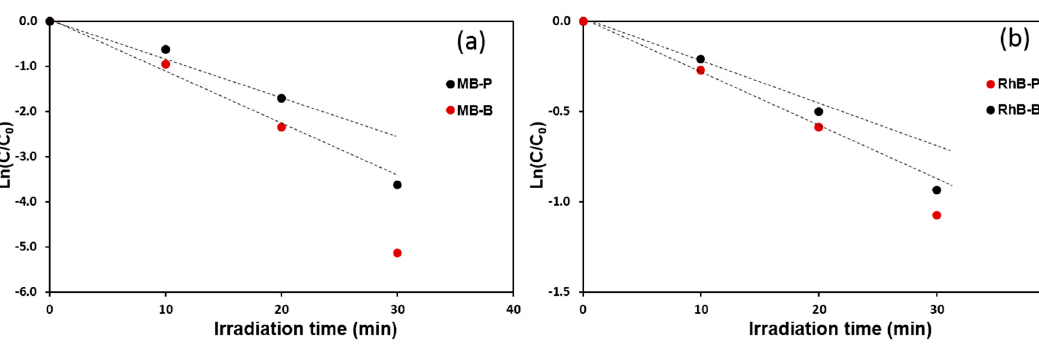
Figure 9. Kinetic plot of Ln(C/C 0 ) vs. time of irradiation for photocatalytic degradation of ( a ) MB dye and ( b ) with RhB dye.